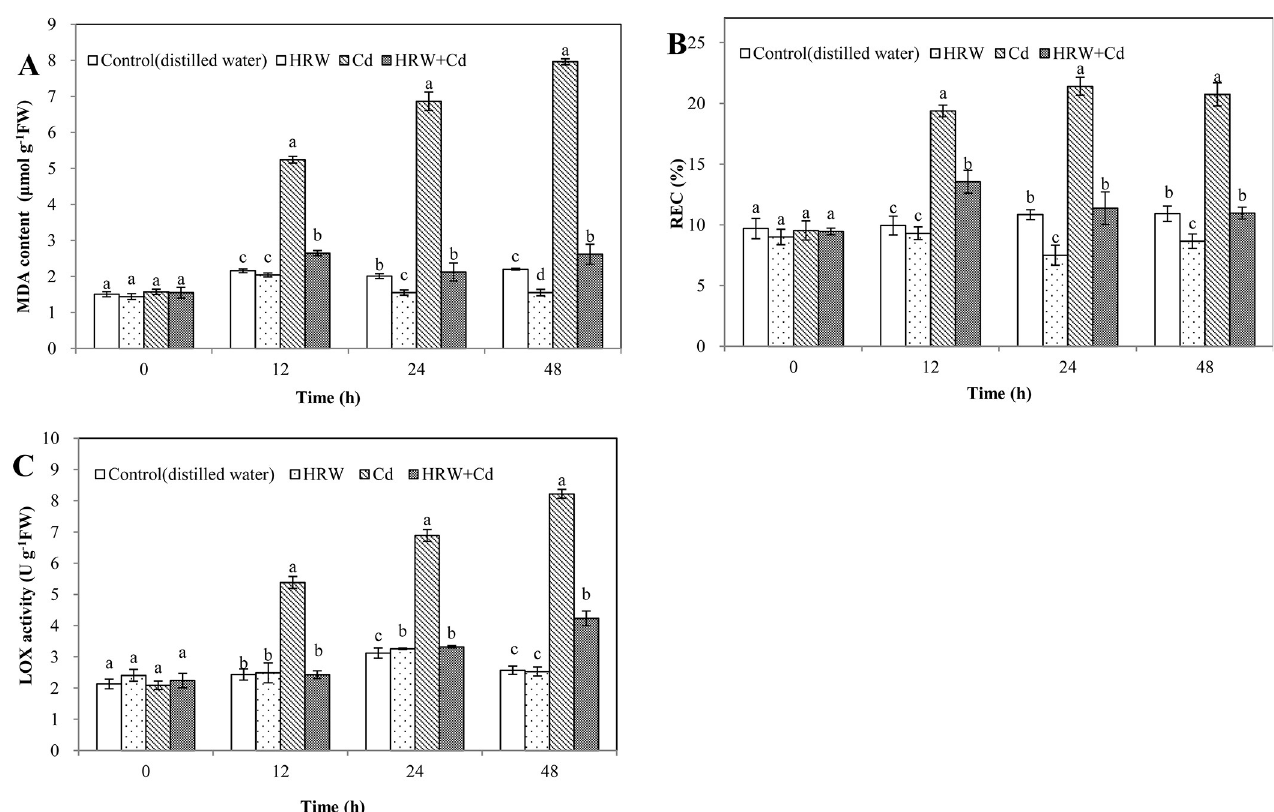
Fig 3. Effects of HRW on malondialdehyde (MDA) content, relative electrical conductivity (REC) and lipoxygenase (LOX) activity during adventitious root development in cucumber explants under Cd stress. The primary roots were removed from hypocotyls of 5-day-old cucumber seedlings. Explants were incubated for 2 d with distilled water (control), 50%HRW, 1 μ M Cd(NO 3 ) 2 , 50%HRW+1 μ M Cd(NO 3 ) 2 . MDA content ( A ), relative conductivity ( B ) and LOX activity ( C ) were measured at 0, 12, 24 and 48 h and expressed as mean ± SE, respectively. Bars not sharing the same letters were significantly different ( P <